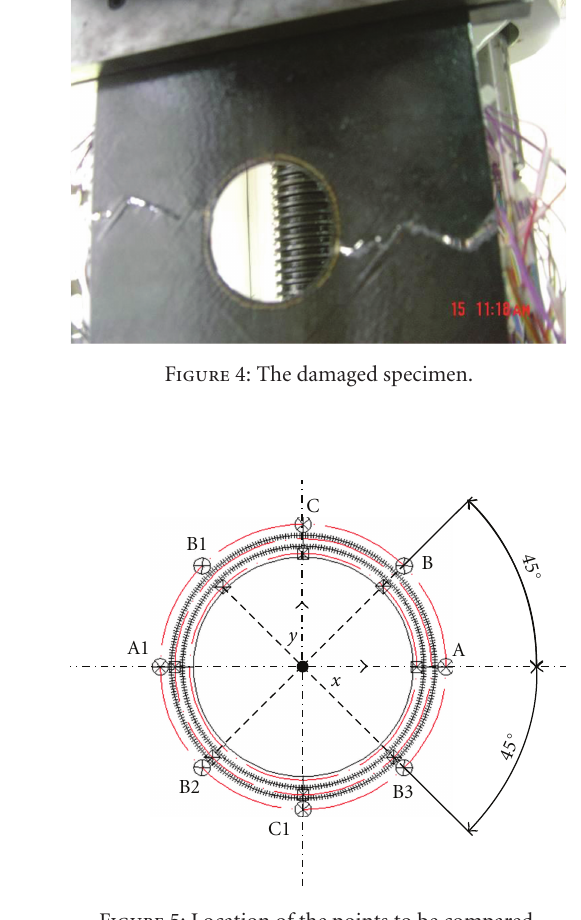
Figure 5: Location of the points to be